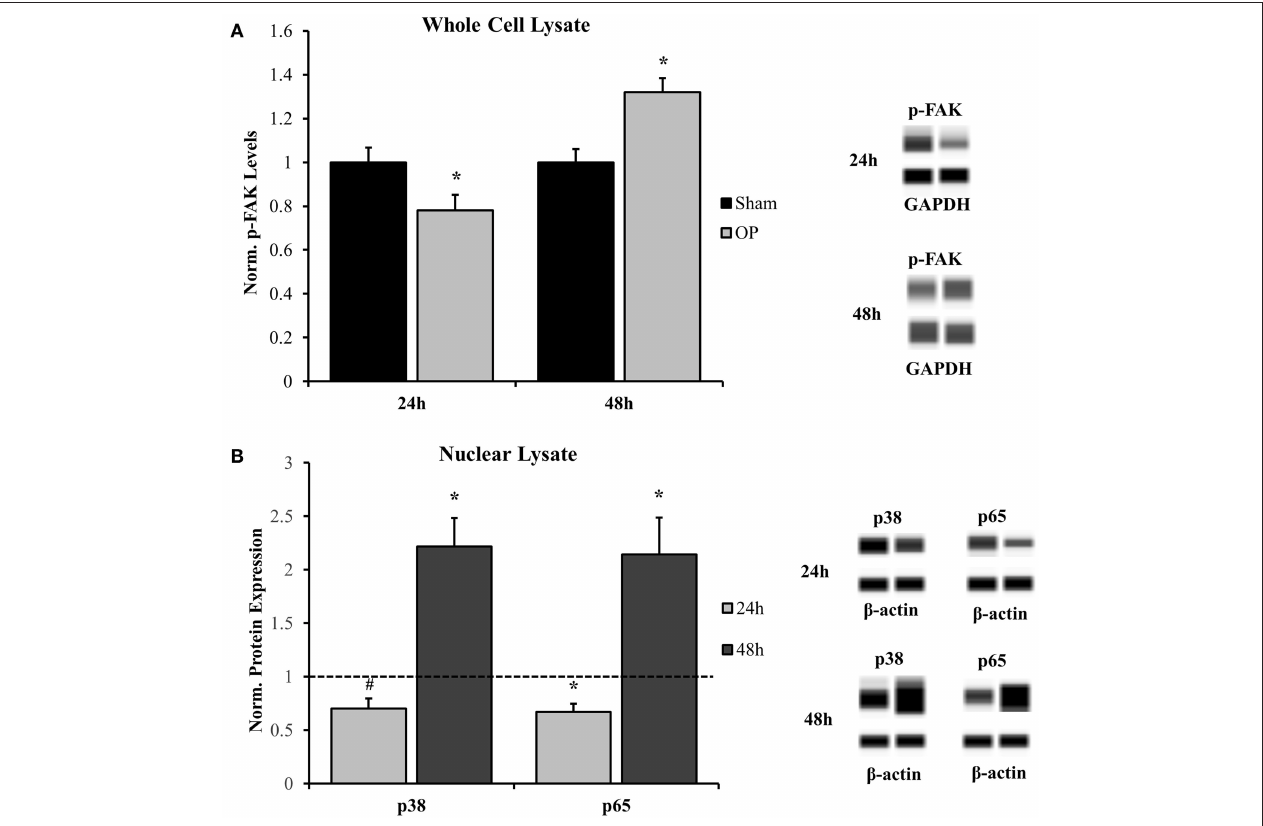
FIGURE 6 | Western blot analysis for whole cell and nuclear signal transduction proteins. (A) Phosphorylated FAK (Y397) was significantly decreased at 24h and significantly increased at 48h as compared to sham. (B) Nuclear localization of corresponding signal transduction molecules, p38, and p65, were decreased at 24h and increased at 48h as compared to sham. * p < 0.05, # p = 0.056, Data are represented as mean ± SEM, whole cell: n = 9–10/group; nuclear: n =